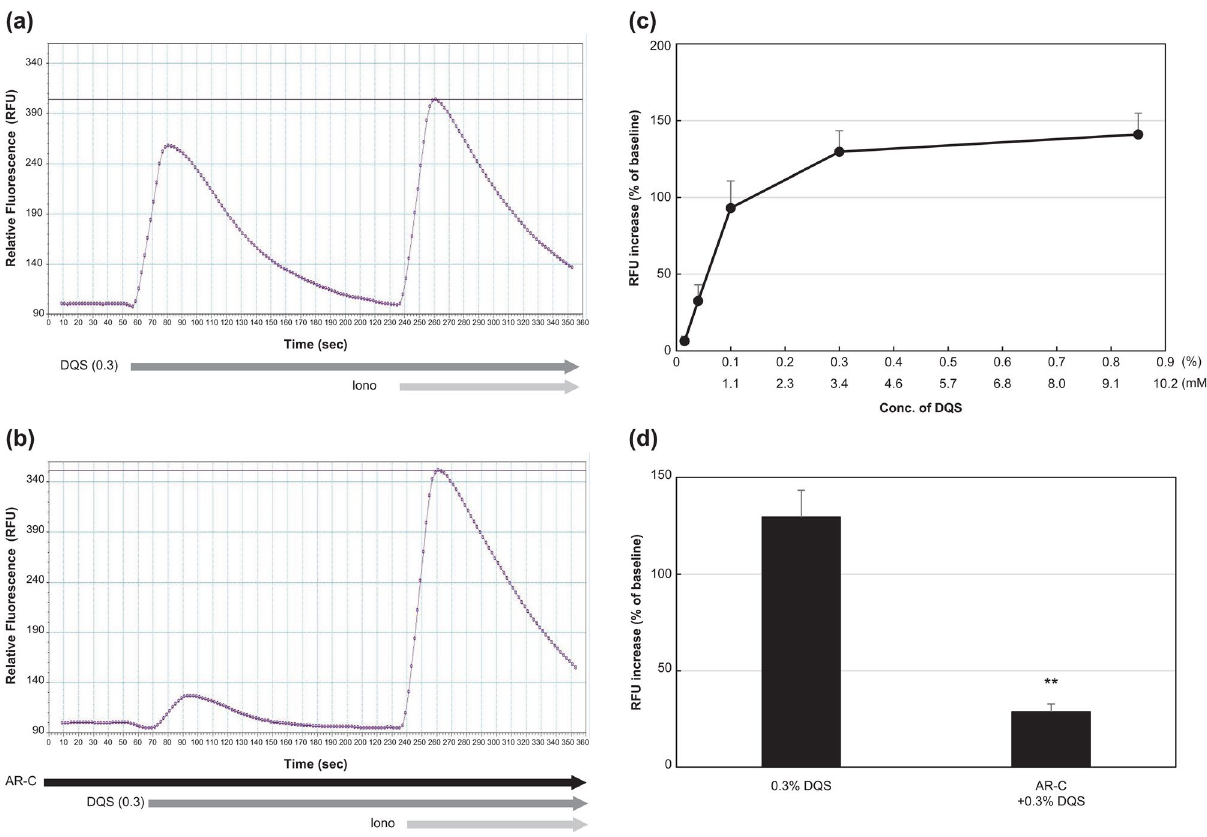
Figure 1. Effect of DQS on intracellular Ca 2+ signalling of cultured meibocytes. ( a ) Representative fluorescence chart of DQS (0.3%) addition following ionomycin (0.5 µM). ( b ) The DQS chart, following ionomycin, under coexistence of AR-C118925XX (3 µM). ( c ) Integrated result of the increase in intracellular Ca 2+ signalling by DQS. ( d ) Integrated result of the suppression of intracellular Ca 2+ signalling by AR-C118925XX (3 µM) in DQS-treated meibocytes. Each value represents mean ± S.E.M. obtained from four independent experiments. **p < 0.01, compared with DQS